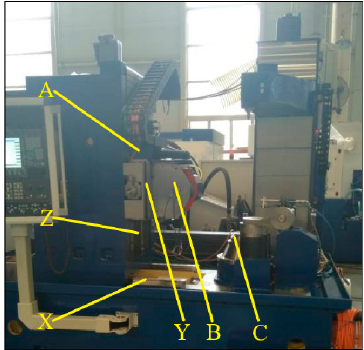
Figure 10. Multi-axis machine tool that was investigated.